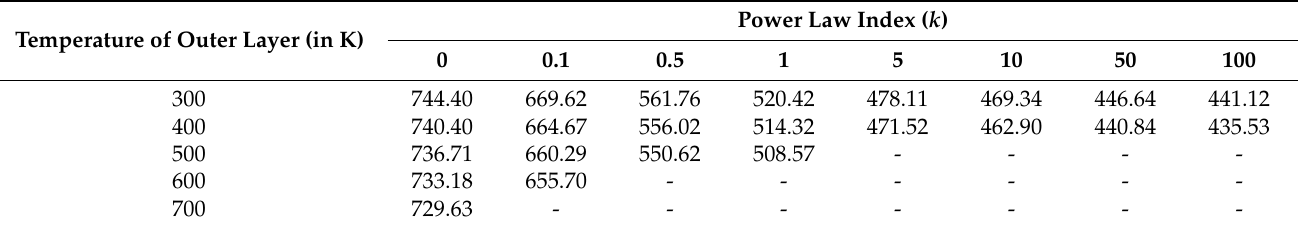
Table 10. Critical buckling temperature (in K) of an aluminum/aluminum oxide FGM shell under linear temperature rise for different material composition in re-entry vehicle nose structures.